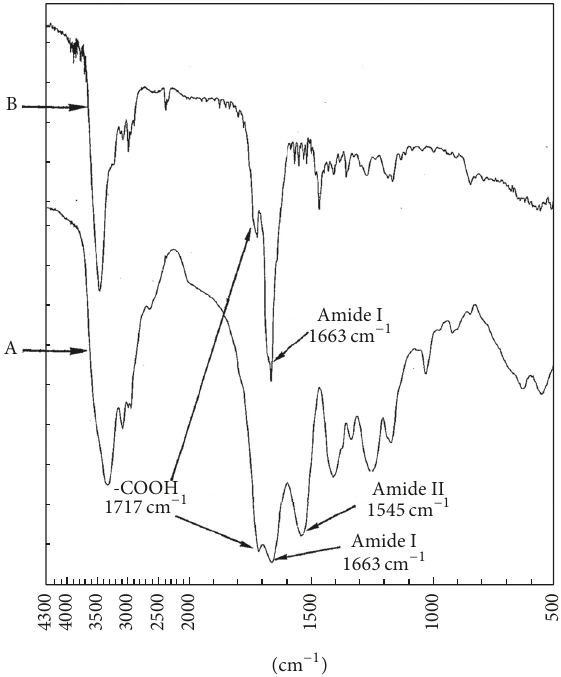
Figure 13: IR spectra of the lower molecular weight fractions obtained from Boc-Gly-Gly-L-Asp (A) at 120 ∘ C for 4h and Boc-L- Val-L-Asp (B) at 130 ∘ C for 2 h in the reaction heating reactions. peptide. Therefore, the lower molecular weight fraction